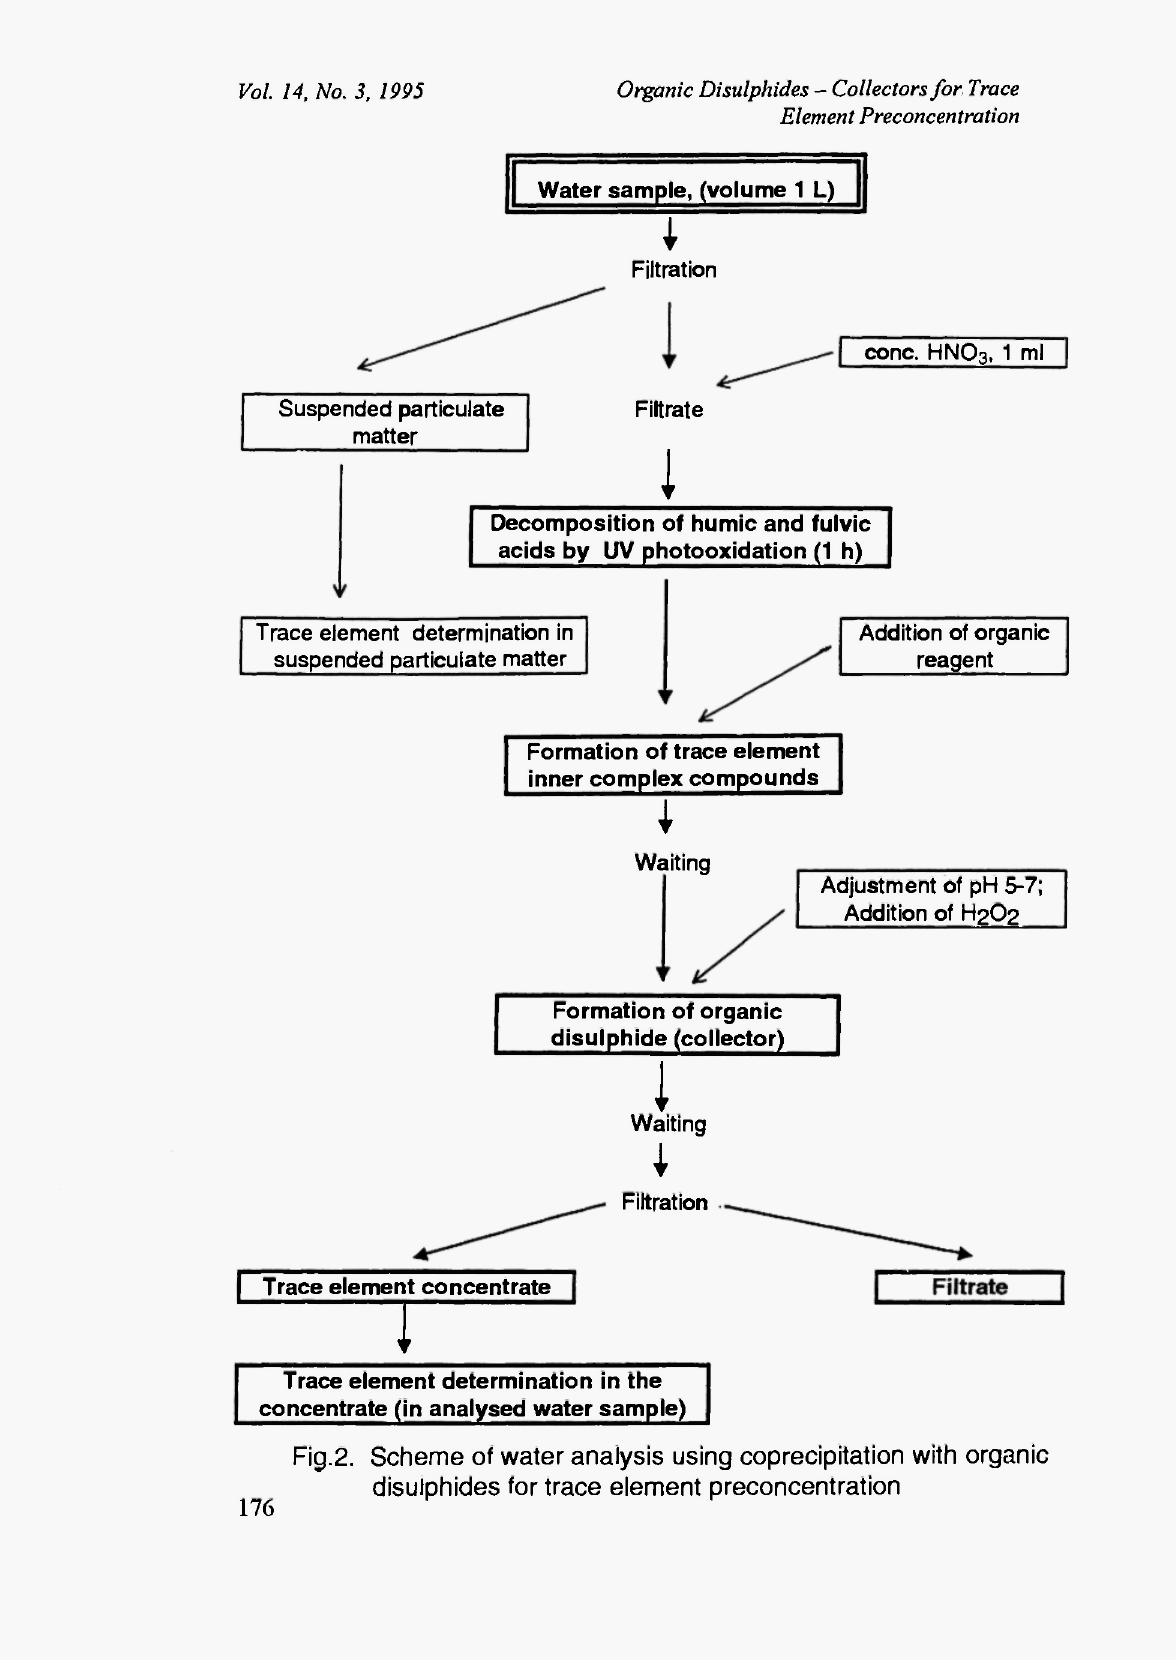
Fig.2. Scheme of water analysis using coprecipitation with